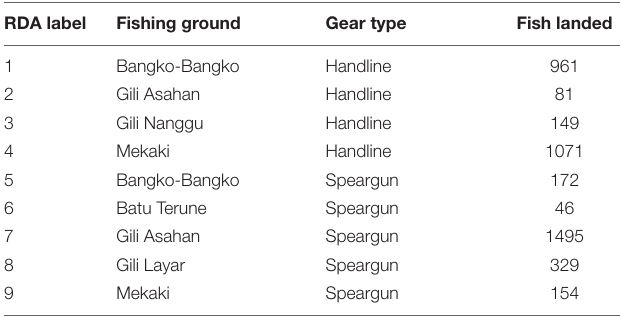
TABLE 2 | Fishing ground, gear type, and number of individual fish landed and used in the redundancy analysis